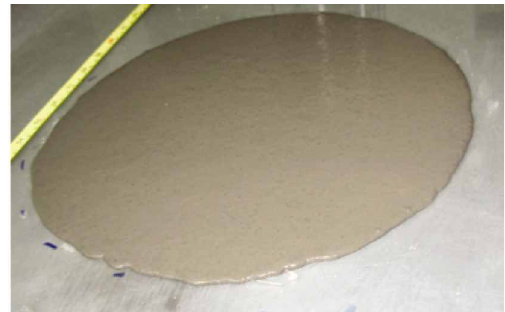
Fig. 16. Slump flow of mortar of self-compacting mortar with w/c = 0.15; flow diameter = 39